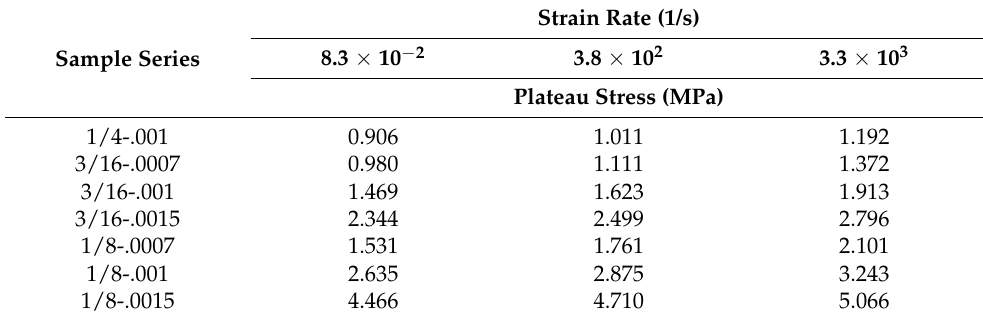
Table 4. Summary of plateau stress values obtained during compression of all types of structures at three strain rates.